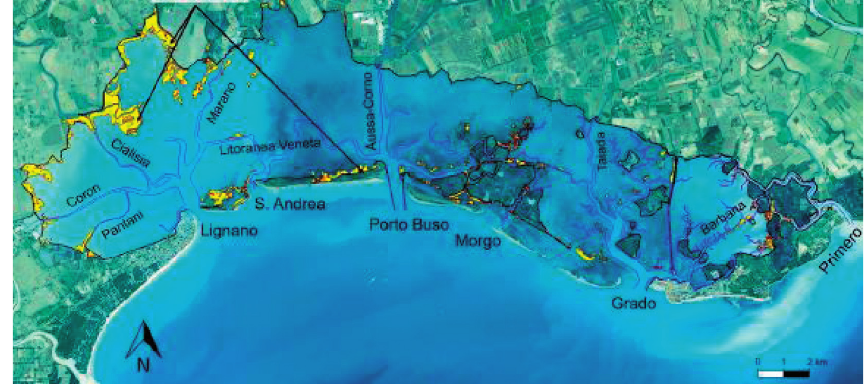
Figure 1: Overview of the Grado Lagoon.